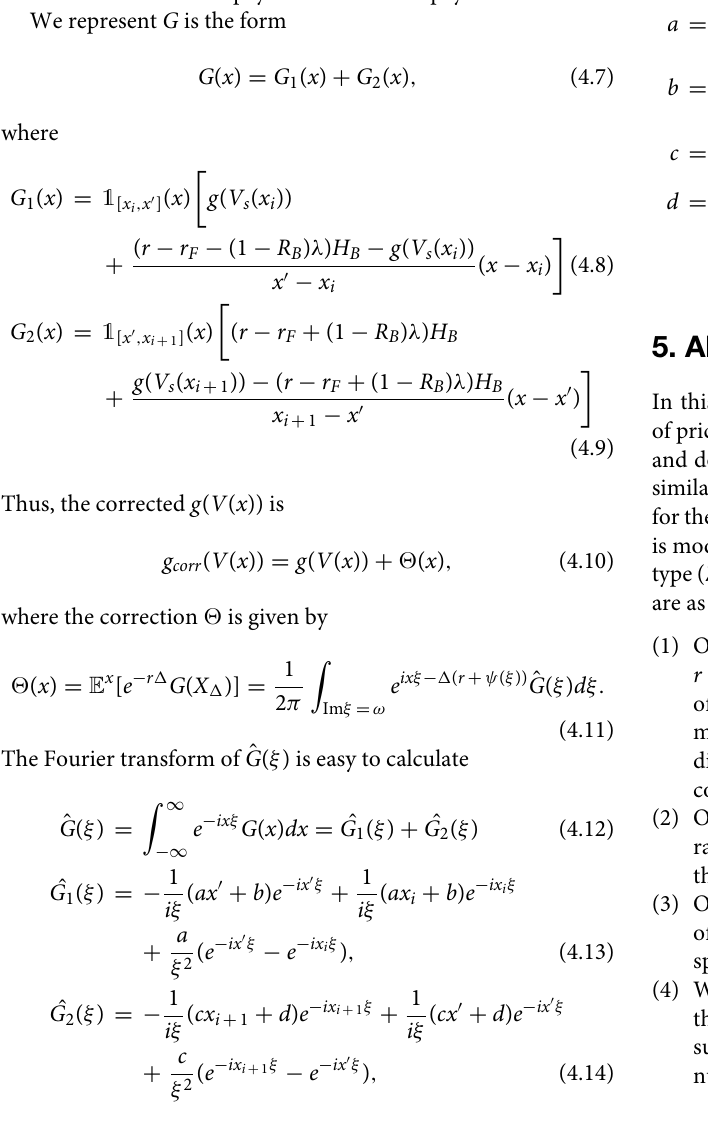
the European option with the payoff G ( x ) that is the difference between the dashed line payoff and solid line